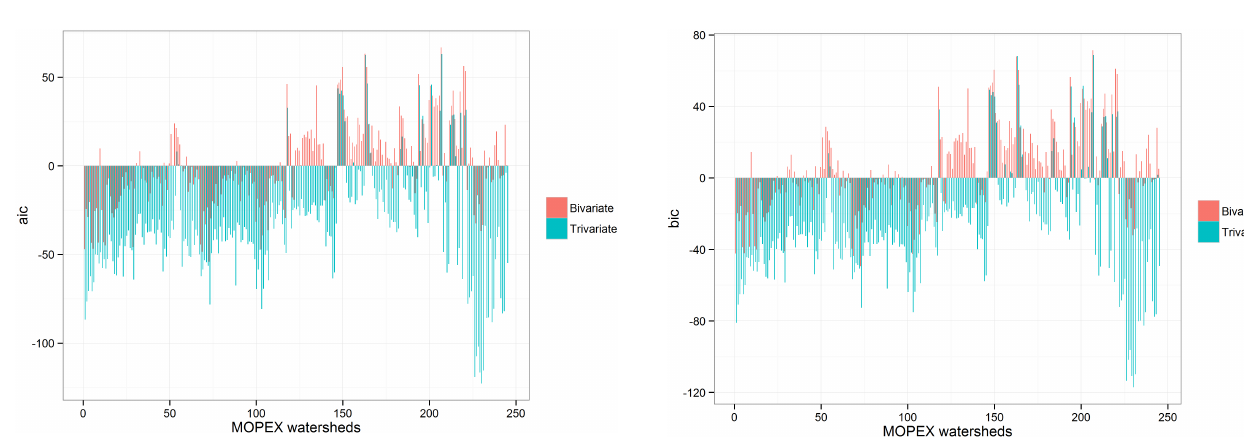
Figure 3. BIC values of the bivariate and trivariate models for the selected MOPEX